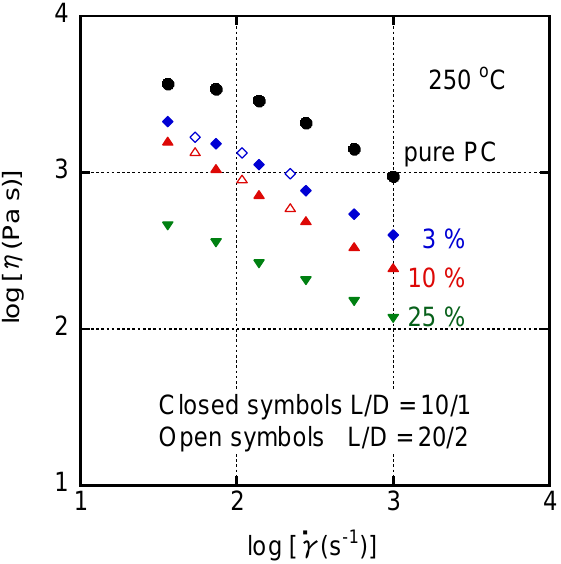
. γ at 250 ◦ C for PC (circles),